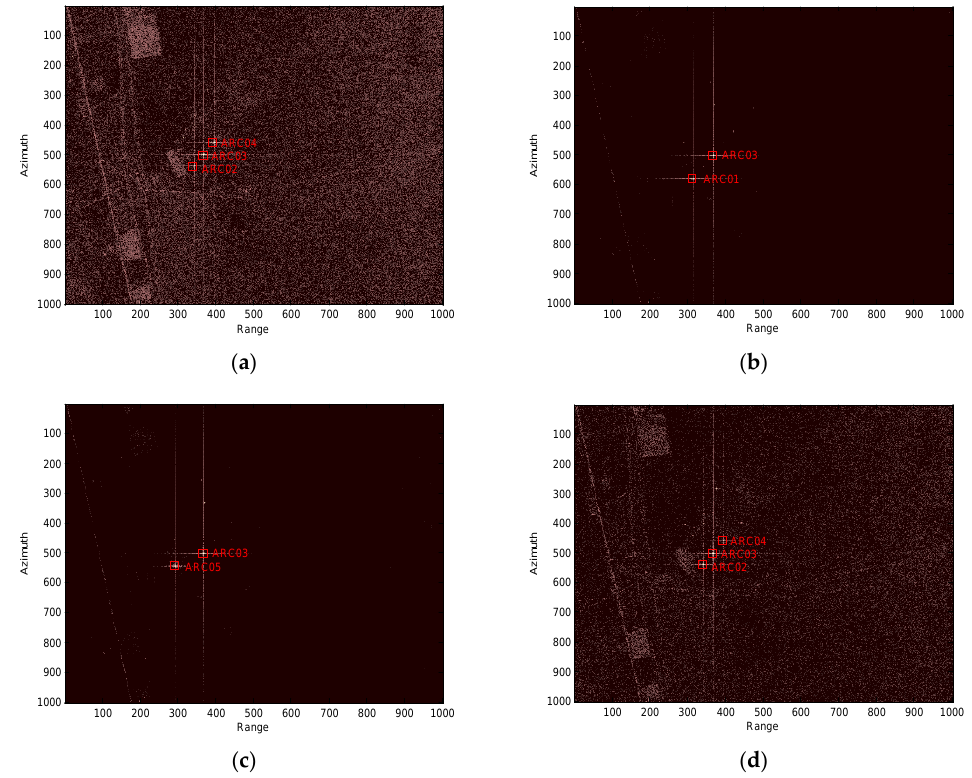
Figure 10. Images of the calibration field of the GF-3 for one pass. ( a ) HH image. ( b ) HV image. ( c ) VH image. ( d ) VV image. Table 4. Scattering matrix setup.